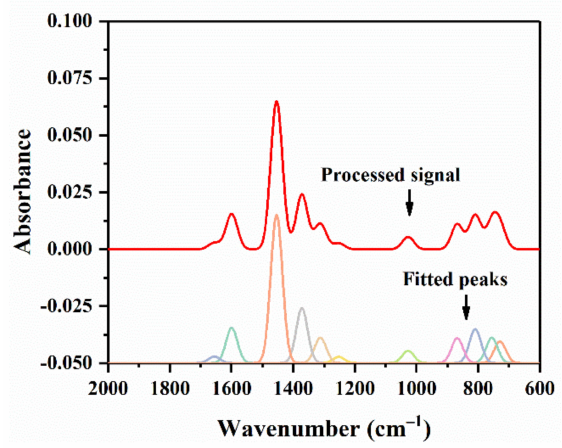
Figure 13. Curve-fitting analysis of FTIR for quantitative